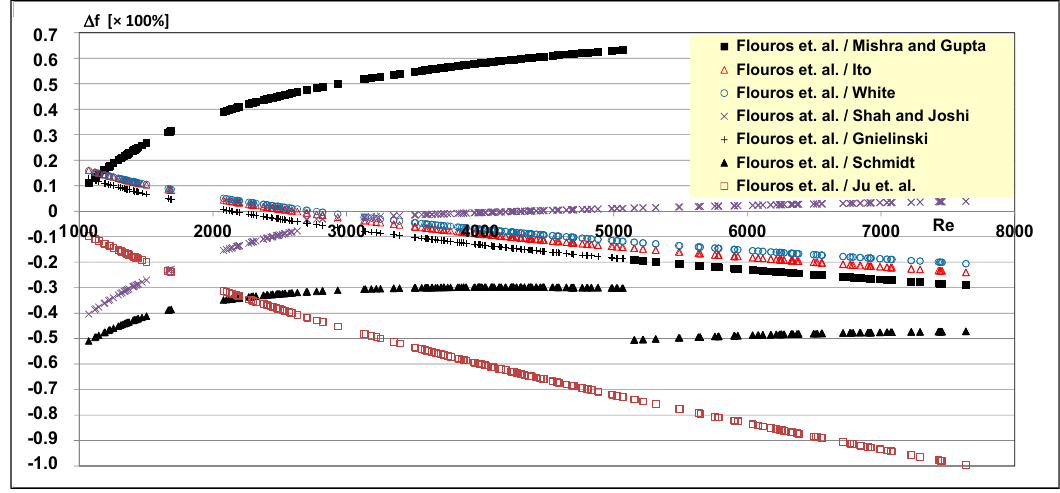
Figure 10. The percentage deviation of the author’s pressure loss coefficient to other authors up to Re = 7600.